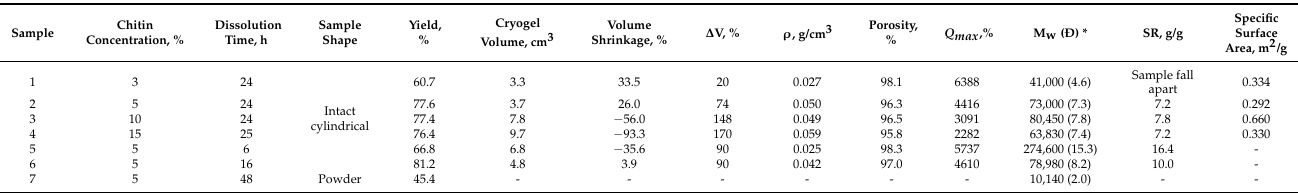
Table 1. Dissolution conditions and characteristics of chitin cryogels prepared from 3–15% chitin solutions in 85% phosphoric acid at 20 ± 3 ◦